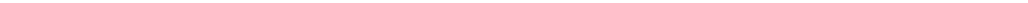
(see fi gure on previous page) Fig. 3 CTC KI/Cre mice are not cognitively impaired. a, b NOR and c – e Barnes maze analyses of 3 – 25-month-old CTC KI/Cre (3 M: n = 15, 9 M: n = 16, 18 M: n = 13, 25 M: n = 9 for NOR and n = 7 for Barnes maze), CTO KI/Cre (3 M: n = 14 for NOR and n = 15 for Barnes maze, 9 M: n = 15, 18 M: n = 14, 25 M: n = 17), CTC KI/WT (3 M: n = 15, 9 M: n = 13, 18 M: n = 15, 25 M: n = 14), CTO KI/WT (3 M: n = 16, 9 M: n = 15, 18 M: n = 17, 25 M: n = 16), WT/Cre (3 M: n = 16, 9 M: n = 15, 18 M: n = 14, 25 M: n = 10), and WT/WT (3 M: n = 15 for NOR and n = 14 for Barnes maze, 9 M: n = 16, 18 M: n = 17, 25 M: n = 18 for NOR and n = 17 for Barnes maze). a Discrimination NOR index. Red line: cut-off for impaired mice (discrimination index = 0.1). b Percentage of NOR impaired mice. c Number of primary errors and latency to the target, and d percentage of pokes made to each hole during the Barnes maze probe test. T target hole. e Percentage of Barnes maze impaired mice. * p < 0.05 vs 3-month-old WT/WT, Fisher ’ s exact test. a, c Data represent the mean ± SEM. Statistical evaluations were done with One-way ANOVA followed by a Bonferroni ’ s post-hoc analysis.